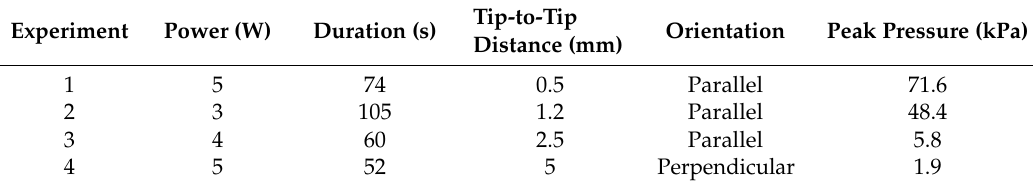
Table 1. Layout of LA experiments.